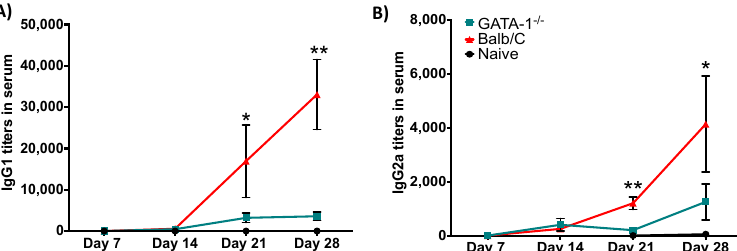
Figure 5. Eosinophil-deficient mice failed to generate protective antibodies. WT or EO mice were intranasally challenged with 50 µ L of PBS or PBS containing 5 × 10 5 Bb D btrS , in two independent experiments. At different days, mice were euthanized, and serum was collected to perform ELISA, to evaluate anti-Bb antibody titers (results are the average of two independent assays in triplicate). IgG1 ( A ) and IgG2a ( B ) were evaluated. The data are shown as average and SEM; * p < 0.05 and ** p < 0.01, using Student t -test. n = 6.